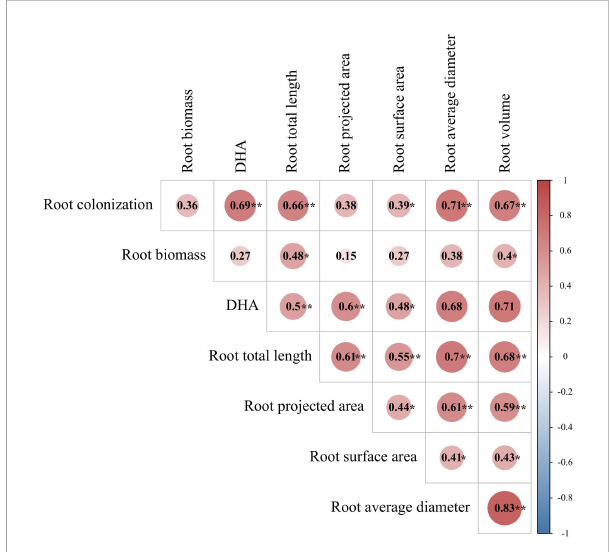
FIGURE 7 Correlation heat map of root-related indicators. **Signi fi cant at p < 0.01 ; *signi fi cant at p < 0.05 .The same